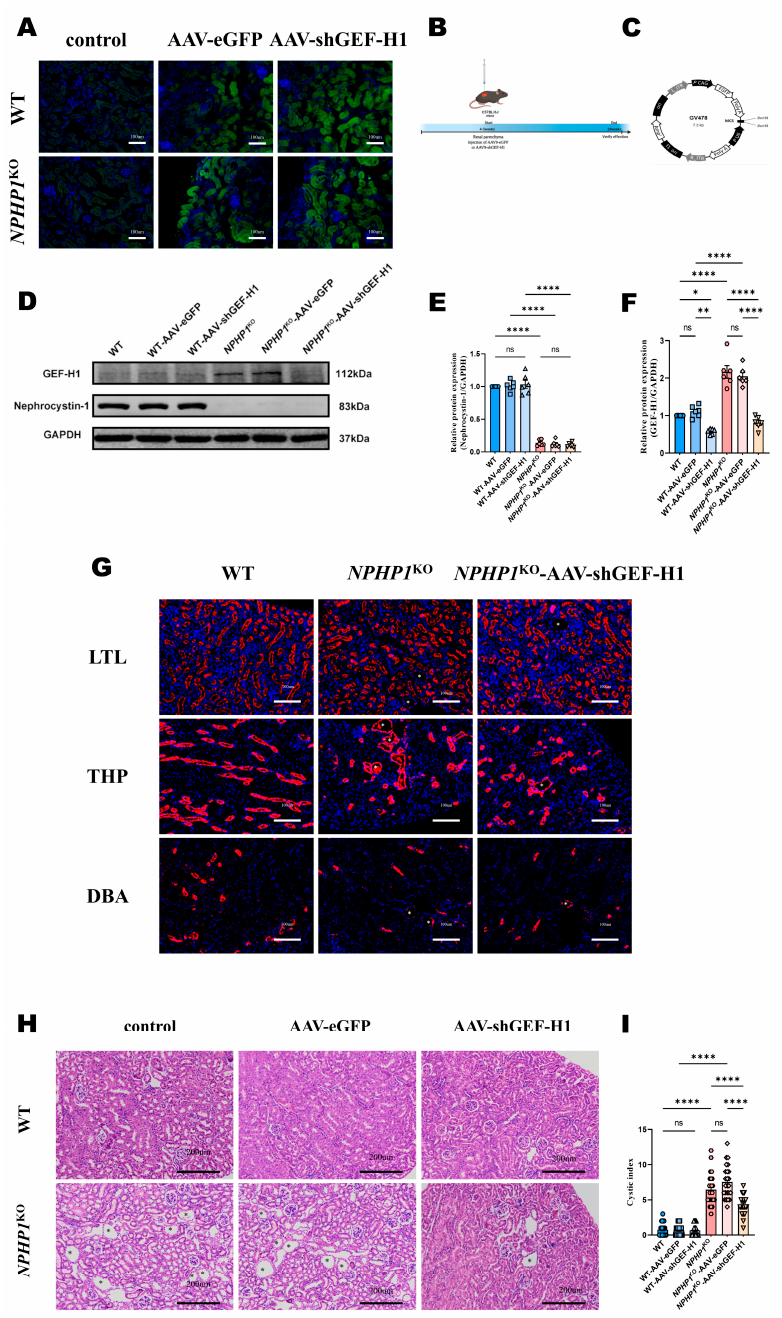
Figure 2. GEF-H1 knockdown reduced renal cyst formation in NPHP1 KO mice compared to WT mice. ( A ): Immunofluorescence analysis of adeno-associated virus (AAV) transfection efficiency. AAV-eGFP and AAV-shGEF-H1 transduced kidneys expressed eGFP (green). The sections were counterstained with DAPI (blue). (Light microscope, scale bar = 100 µ m). ( B ): Time course of AAV9-mediated GEF-H1 knockdown. ( C ): Structural diagram of the AAV vector GV478. ( D – F ): The expression of GEF-H1 and nephrocystin-1 levels in mouse kidney tissue were evaluated by Western blot ( D ) and densitometry analysis. ( E , F ): Densitometry analysis; n = 6 mice/group). The increased GEF-H1 level of NPHP1 KO mice was then decreased after being transfected with AAV-shGEF-H1. ( G ): Staining of the kidney with lotus tetragonolobus lectin (LTL + means proximal tubules; red), Tamm-Horsfall protein (THP+ means distal convoluted tubules; red), and Dolichus biflorus agglutinin (DBA+ means collecting ducts; red). Scale bar = 100 μ m. ( H ): Mouse kidney histopathological changes (he- matoxylin-eosin (HE) staining, scale bar = 200 μ m). Asterisks indicate the cysts. Cyst formation and